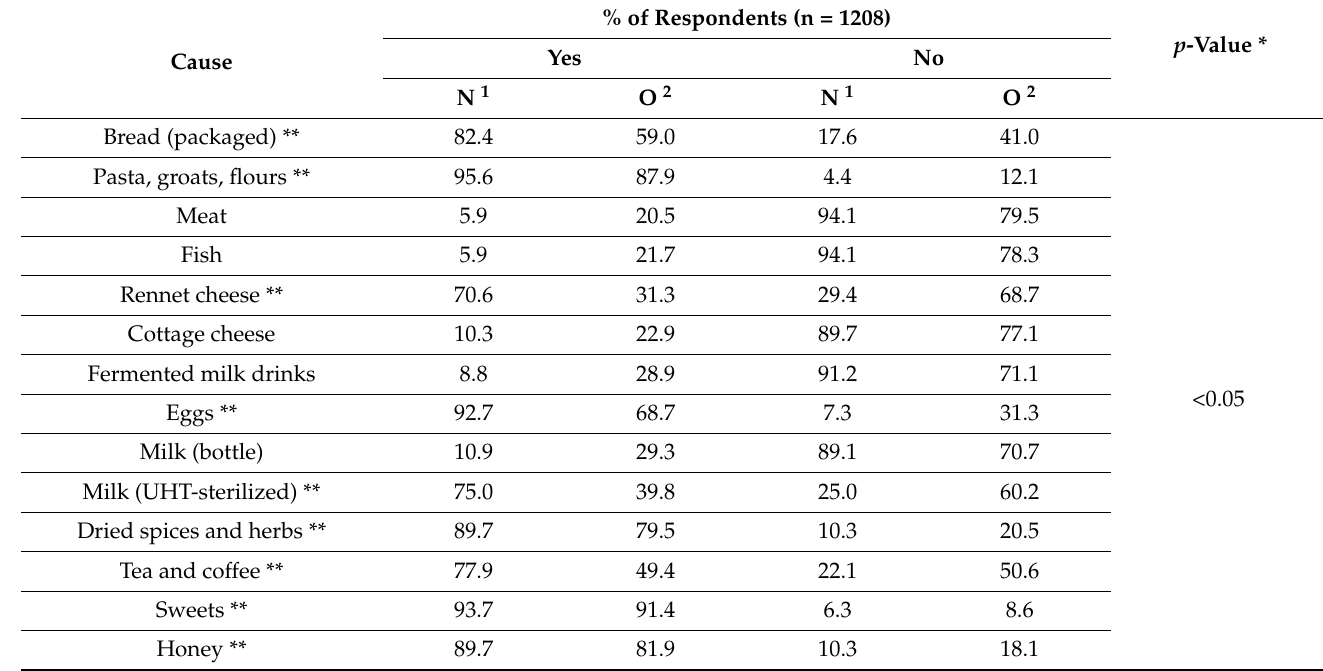
Table 7. Qualifying food products for date marking methods: